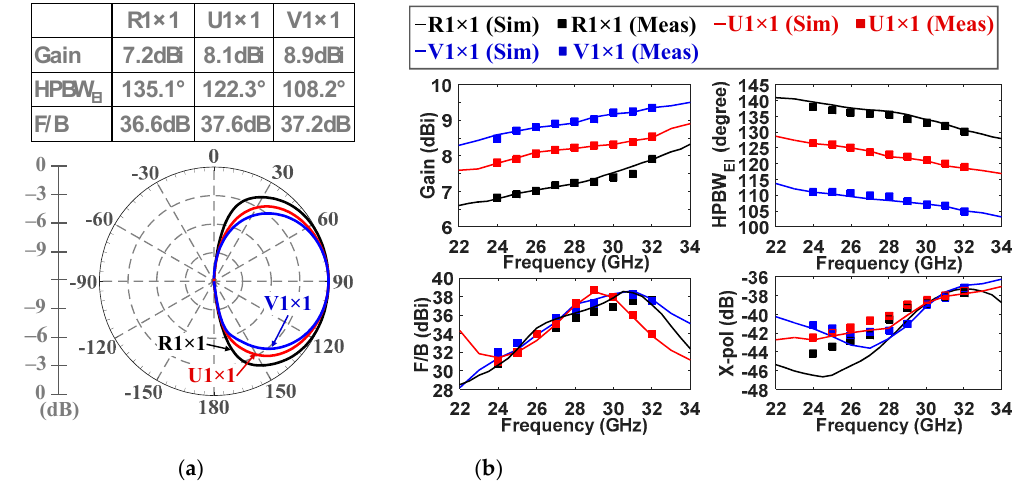
Figure 5. ( a ) The simulated radiation pattern in the elevation plane for the dipole with rectangular (R1 × 1), U- (U1 × 1), and V-fence (V1 × 1) at 28 GHz. ( b ) The simulated and measured radiation performance of the electric dipole with the different fence shapes versus frequency.